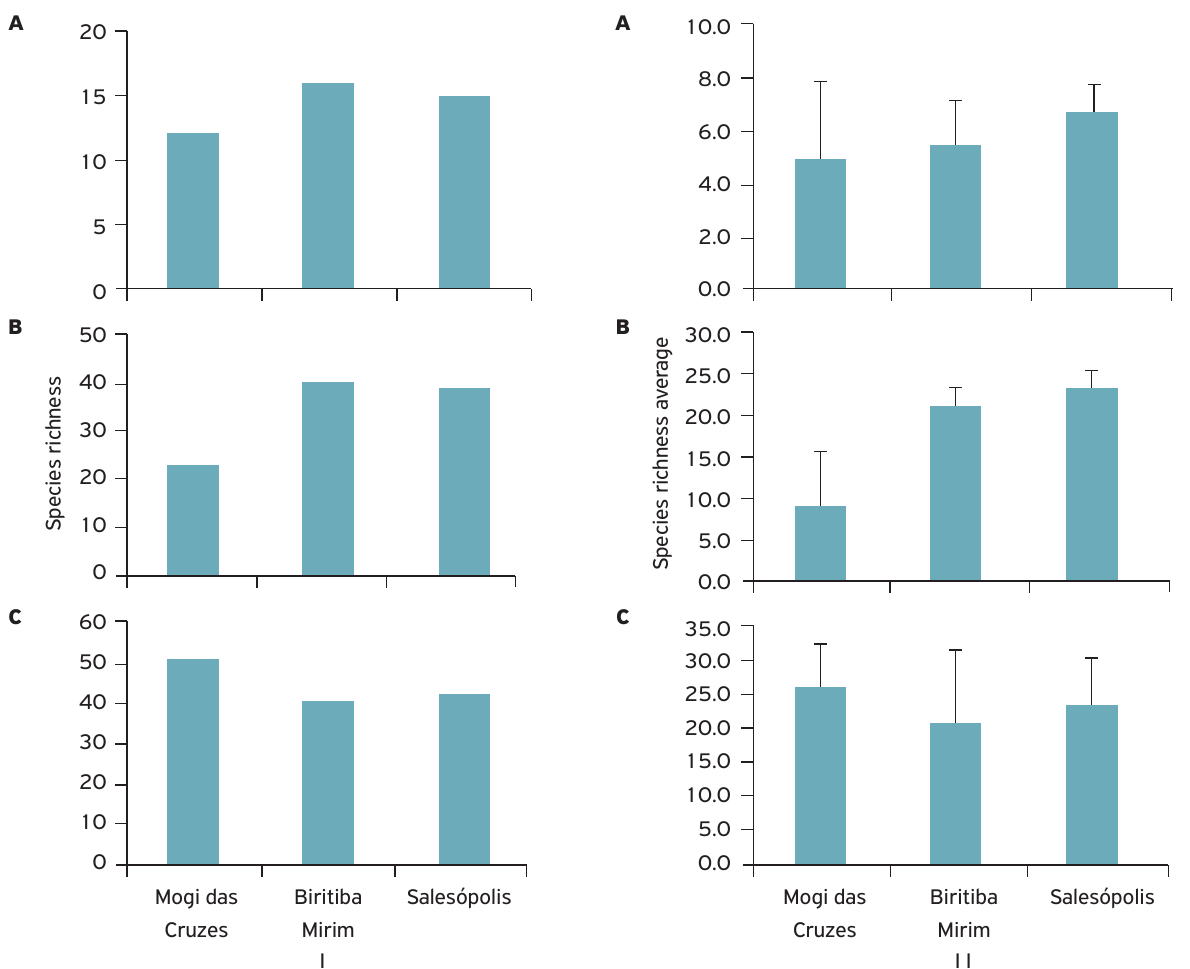
Figure 1. Total (I) and average (II) richness of ants according to the municipality and collection site in the urban centers. (A) area inside the house; (B) area outside the house; (C) squares. Vertical bar: